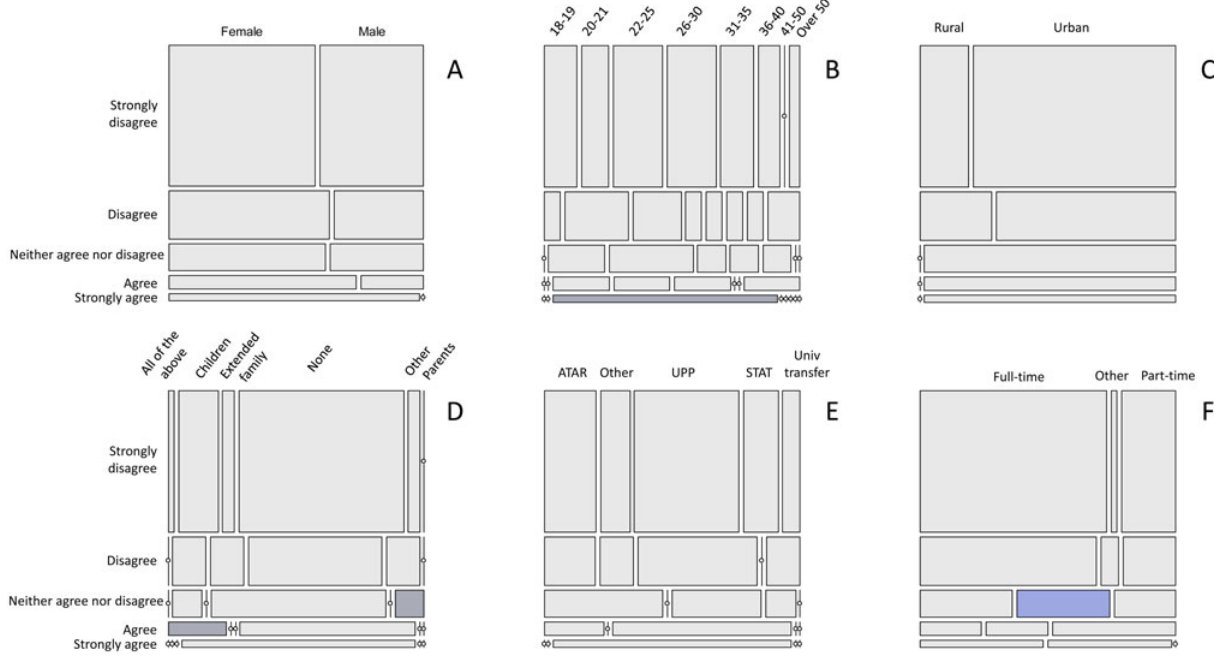
Fig. 3. Mosaic plots representing the association between gender (A), age (B), rurality (C), caring responsibility (D), pathway entry (E) and type of enrolment (F) with withdrawal likelihood. ATAR, Australian Tertiary Admissions Ranking; UPP, University Preparatory Program; STAT, Special Tertiary Admissions Test; Univ transfer, university transfer; Other.